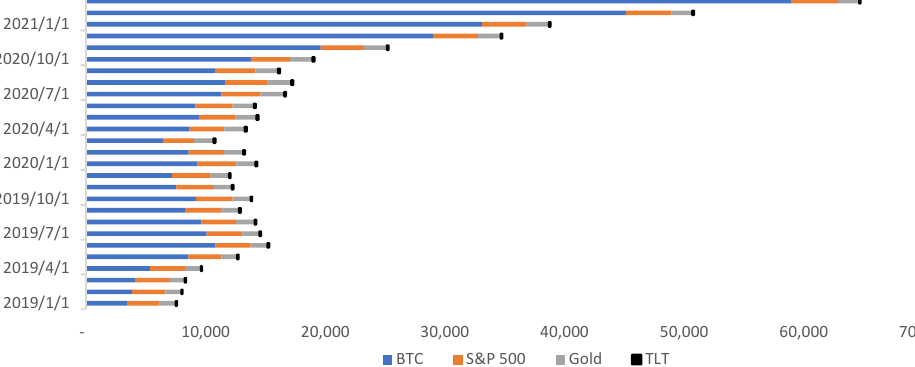
Figure 3. Volatility observations between monthly price changes of four financial investments between 2019 before the COVID outbreak to 2021.